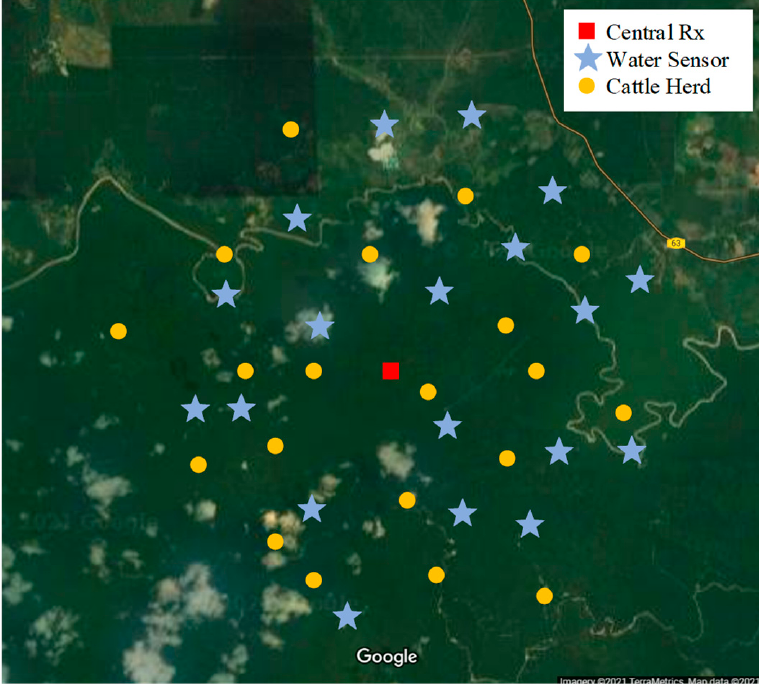
Figure 4. A schematic of the position of the sensors on the considered farm.